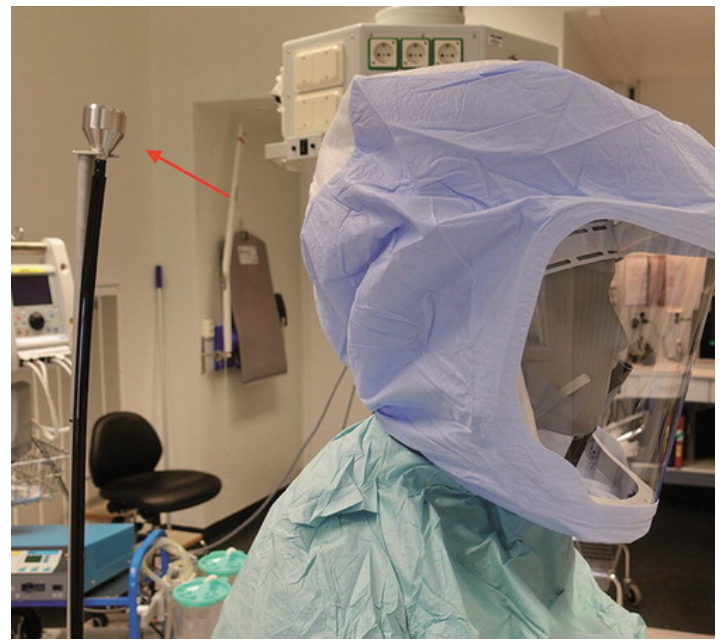
Figure 5. Stryker Flyte modified ventilated helmet using 3D printing to facilitate powered air filter units and improve safety. This image is reprinted under a Creative Commons Attribution 4.0 International License and it is taken from [80].